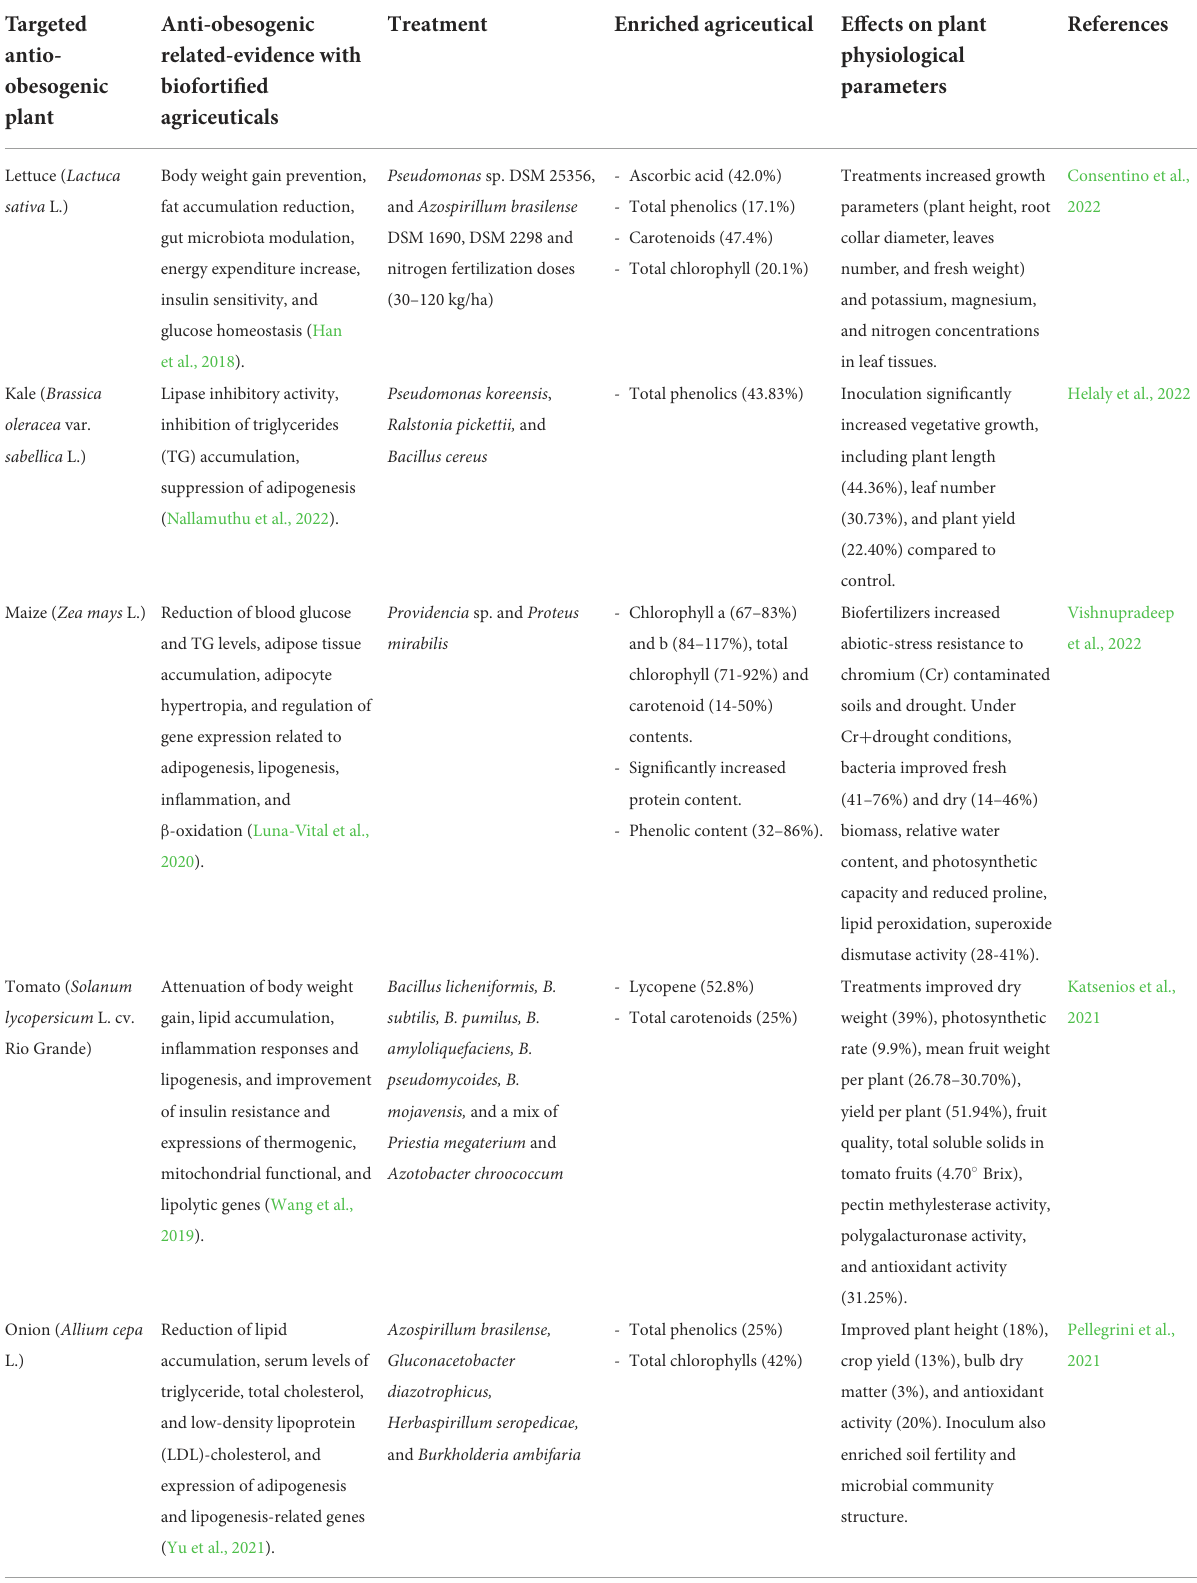
TABLE 1 Studies of biofortification with anti-obesogenic agriceuticals using beneficial soil microorganisms during plant cultivation.